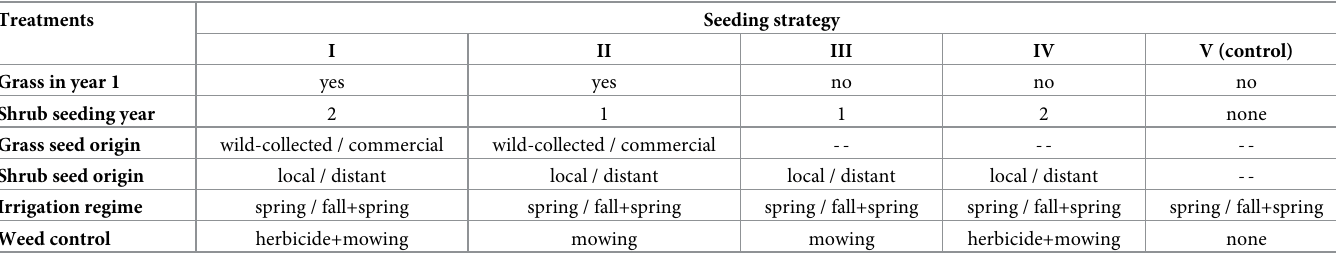
Table 1. Restoration treatments and weed control methods.